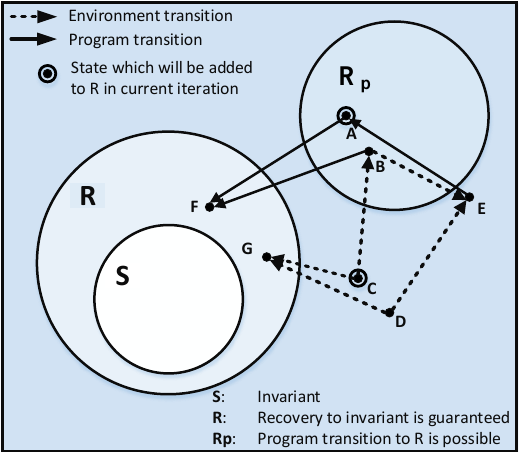
Figure 3. Illustration of how R expands in Algorithm